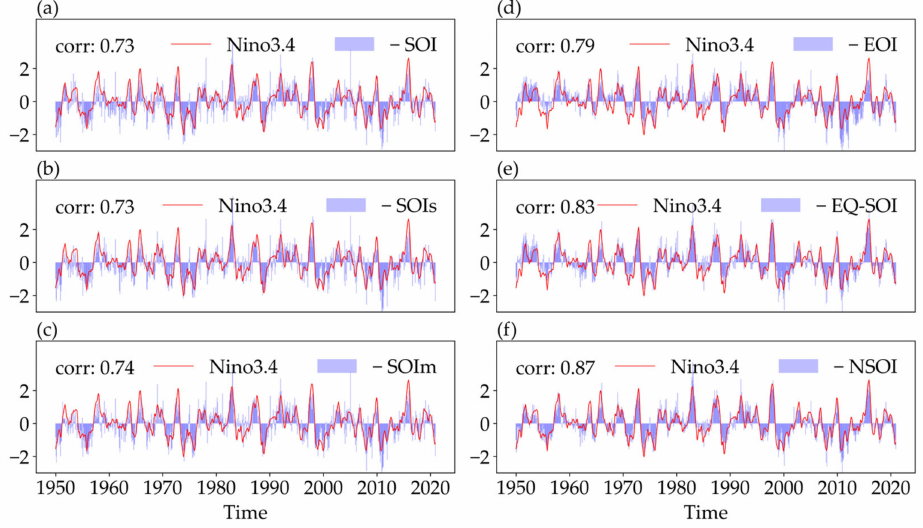
Figure 4. Time series of Niño-3.4 index ( ◦ C; red line) and Southern Oscillation (SO) indexes (blue bar): ( a ) SOI, ( b ) SOIs, ( c ) SOIm, ( d ) EOI, ( e ) EQ-SOI, and ( f ) NSOI during 1950–2020. The number following ‘corr:’ is the absolute value of the correlation coefficient between Niño-3.4 index and SO index in the corresponding